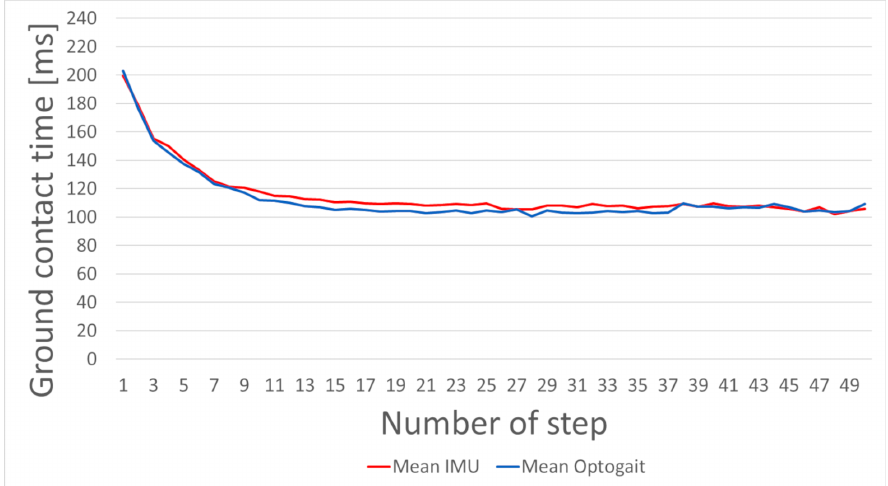
Figure 4. Average GCT of Optogait (blue) and IMU (red) measurements. Only these steps are included, which at least two different athletes performed. All measured data points are summarized to one value for the respective step in the